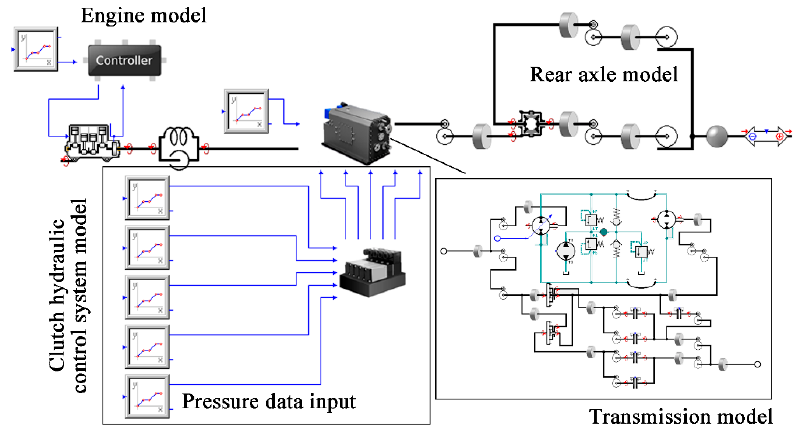
Figure 8. Dynamic model of the CVT tractor.